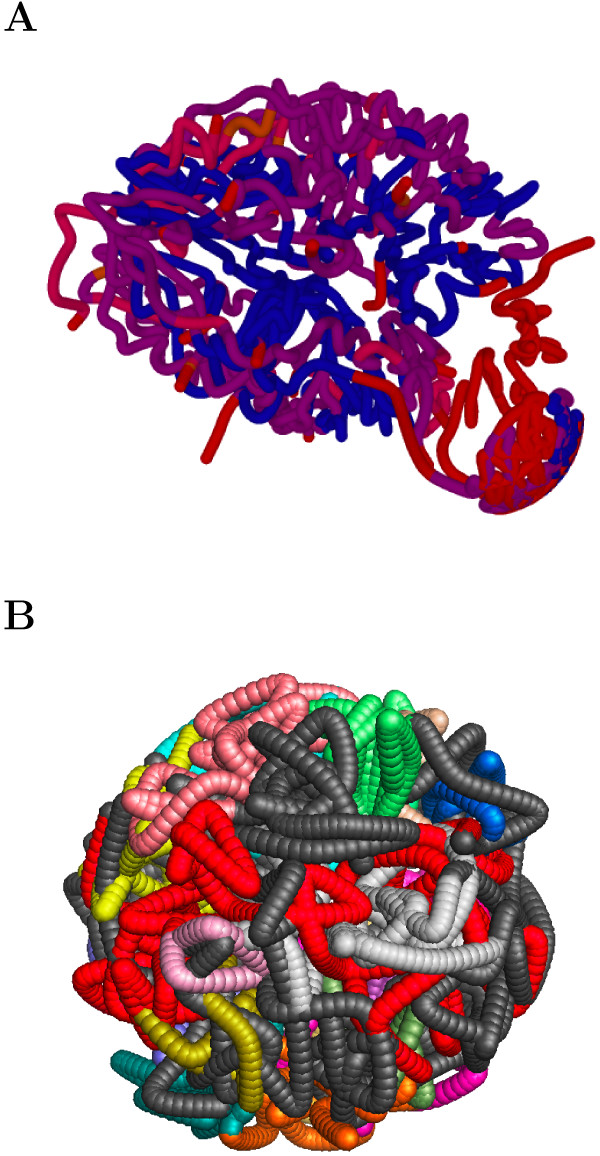
Highlighting structures with rigidity analysis. (A) Confidence in the embedding of the Duan et al. structure. Segments of the genome are colored according to the interaction frequency cutoff at which the segment becomes floppy. Red regions correspond to the 98.8 cutoff% and blue regions are still rigid at the 99.6% cutoff. (B) The Tanizawa et al. structure colored by rigid component for interaction frequency cutoff 99.0%. Dark gray indicates floppy regions. Rigid components in the subtelomeric regions of chromosome 1 are red (see Discussion).